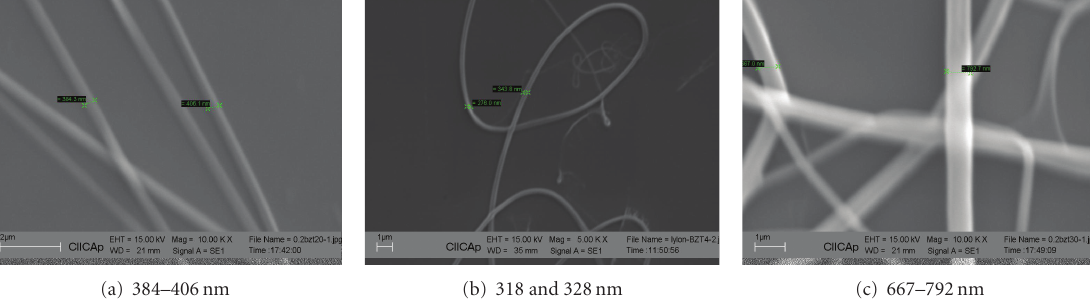
Figure 5: SEM micrographs of Ny-BTAH fibers with di ff erent inhibitor concentrations at 0.2mL/h: (a) Ny-BTAH 10%, (b) Ny-BTAH 20%, and (c) Ny-BTAH 30%.